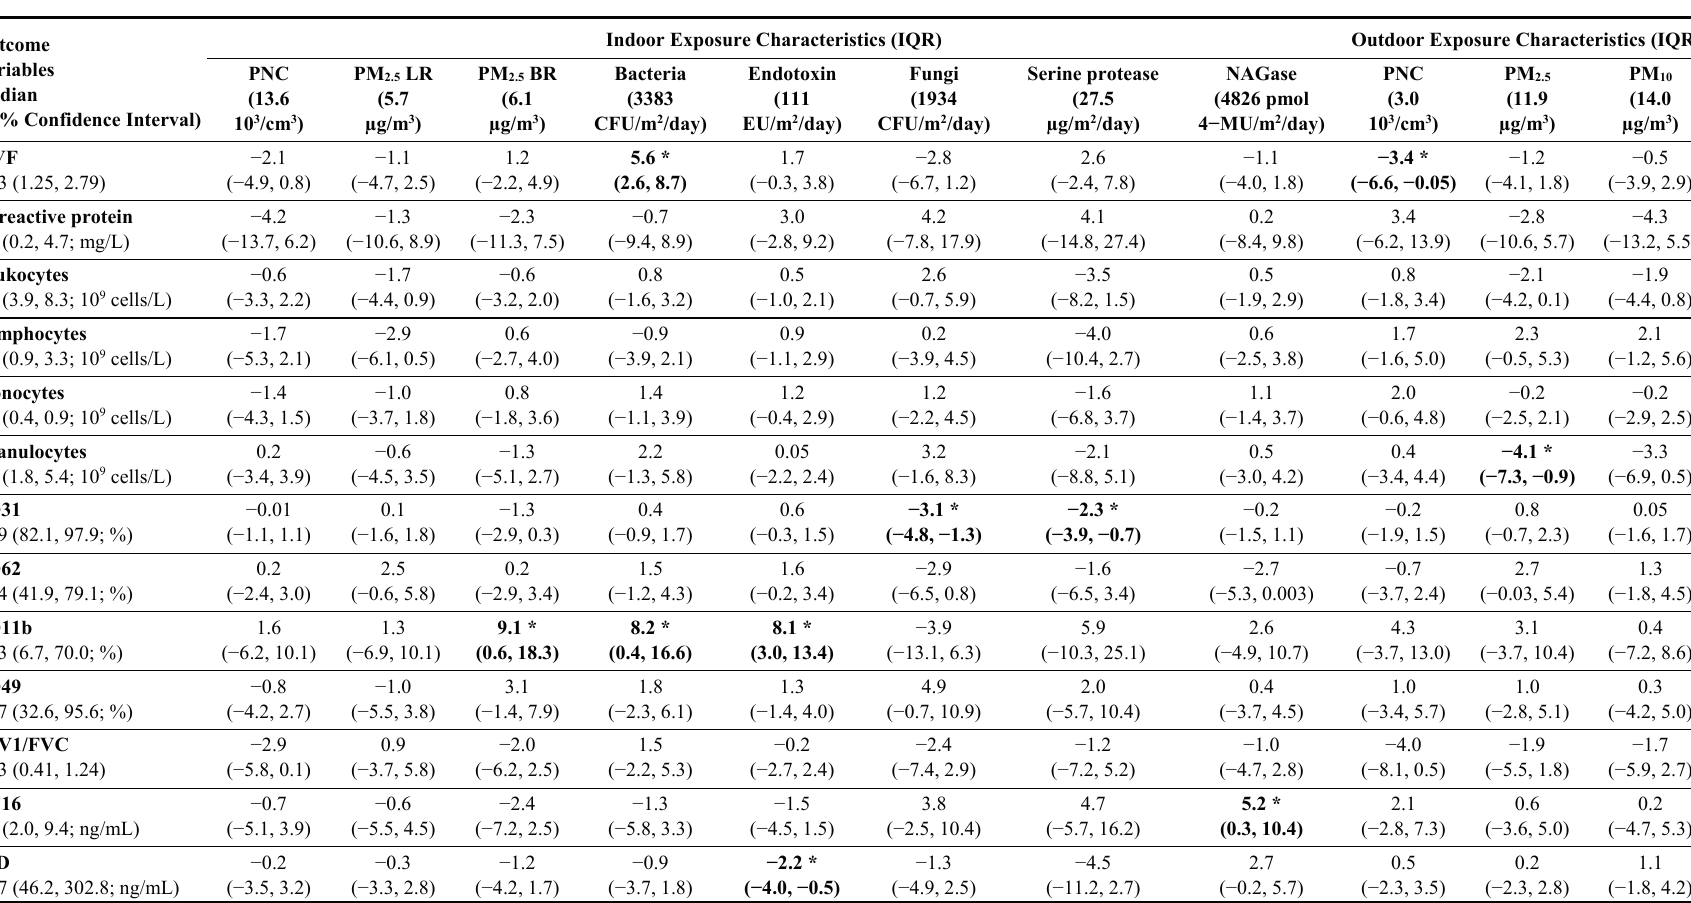
Table 4. Percent changes (95% confidence interval) in outcome levels associated with one interquartile range increase (IQR) in indoor and outdoor exposures, estimated by mixed-effects models with the natural logarithm of the outcomes, accounting for correlation between repeated measurements within subjects and with subjects nested in residence; all models were adjusted for age, gender, BMI, indoor filtration and days of measurements. Associations with outdoor pollutants were further adjusted for outdoor temperature and